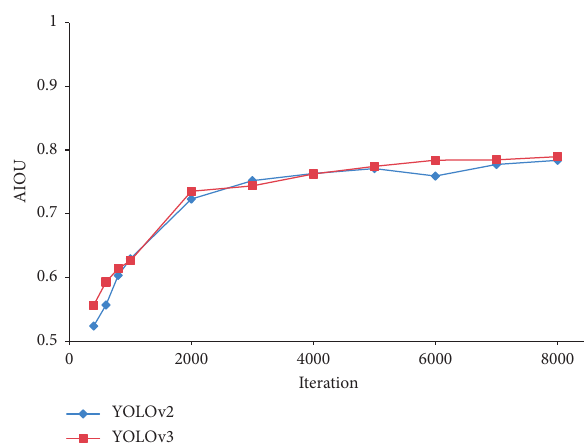
Figure 10: The comparison of AIOU index between YOLOv2/v3 under the testing-set.